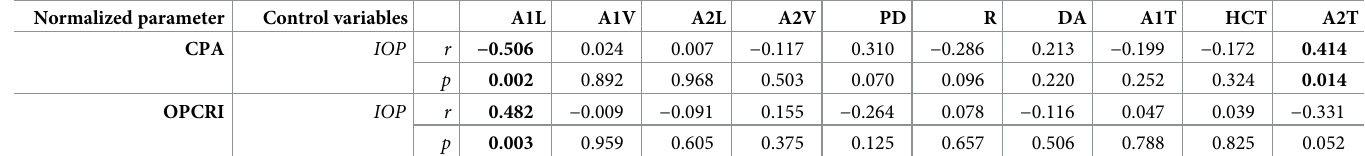
Table 3. Results of partial correlation between normalized corneal pulse amplitude (CPA) or ocular pulse based corneal rigidity index (OPCRI) and normalized corneal deformation parameters, with IOP used as a control variable. Normalized parameter